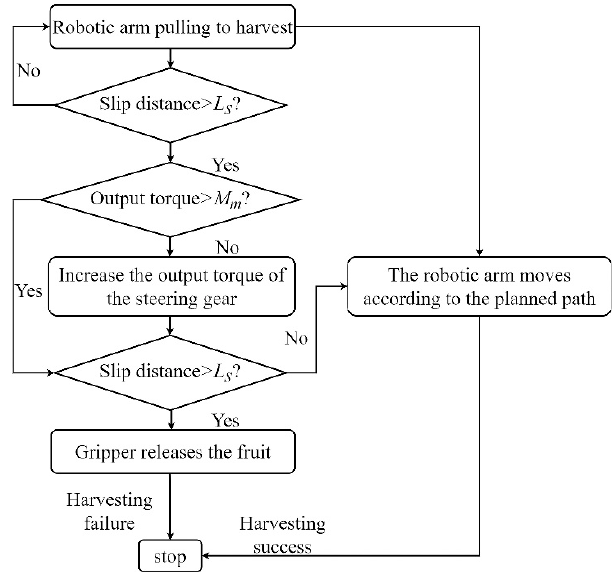
Figure 14. Gripper control method of slip detection.